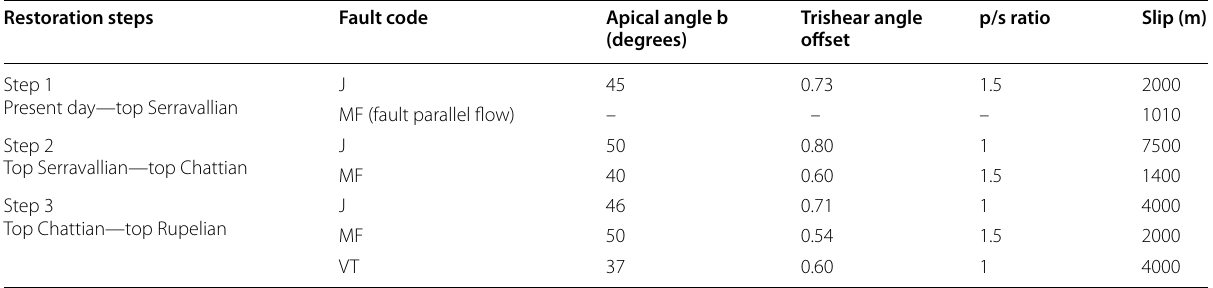
Table 1 list of the parameters adopted for the Trishear kinematic modelling, during the first three steps of restoration; Step 4 was restored with unfolding only Restoration